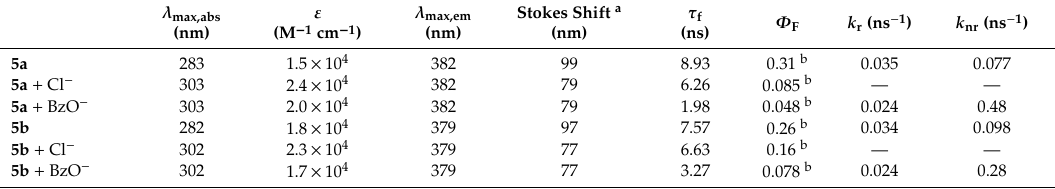
Table 3. Photophysical properties of Naphureas 5a and 5b in CH 2 Cl 2 at 25 ◦ C. λ max,abs (nm)